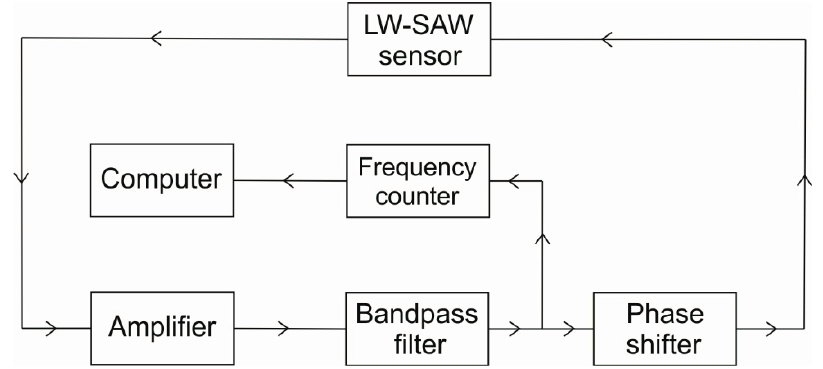
Figure 1. Schematic representation of the Love wave surface acoustic wave (LW-SAW) configured sensor.